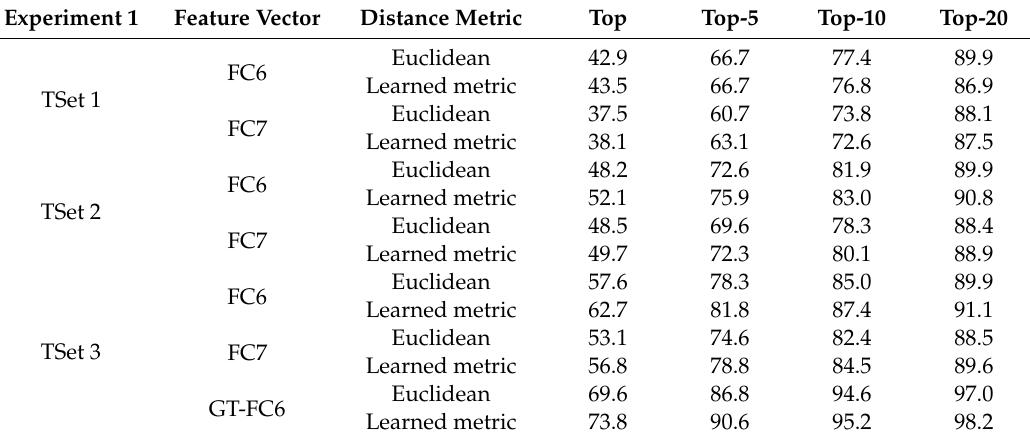
Table 4. Identification rate with di ff erent feature vectors and distance